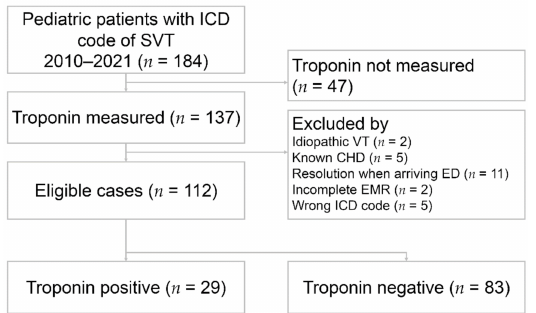
Figure 1. Flow chart of patient selection. ICD: International Classification of Diseases; SVT: supraven- tricular tachycardia; VT: ventricular tachycardia; CHD: congenital heart disease; ED: emergency department; EMR: electrical medical